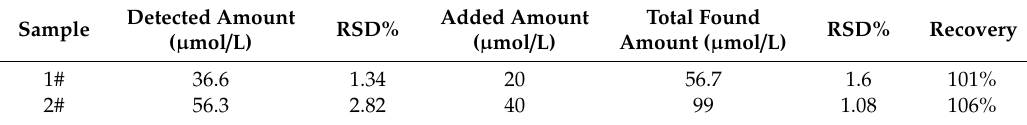
Table 1. The detection of Trp in human serum samples by second-order derivative linear sweep voltammetry (SDLSV) ( n =